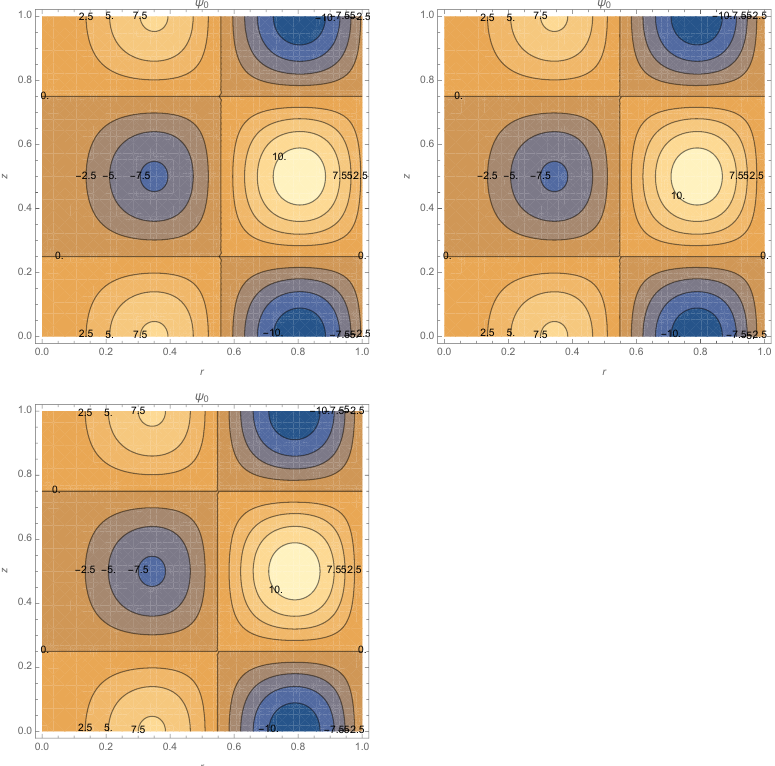
Figure 7. Zero-order function ψ 0 for λ varying in the resonance interval for ψ 1 : λ = 9.3 ( upper left panel ), 9.4 ( upper right panel ), 9.5 ( bottom panel ). No changes in ψ 0 visible. See text for details.